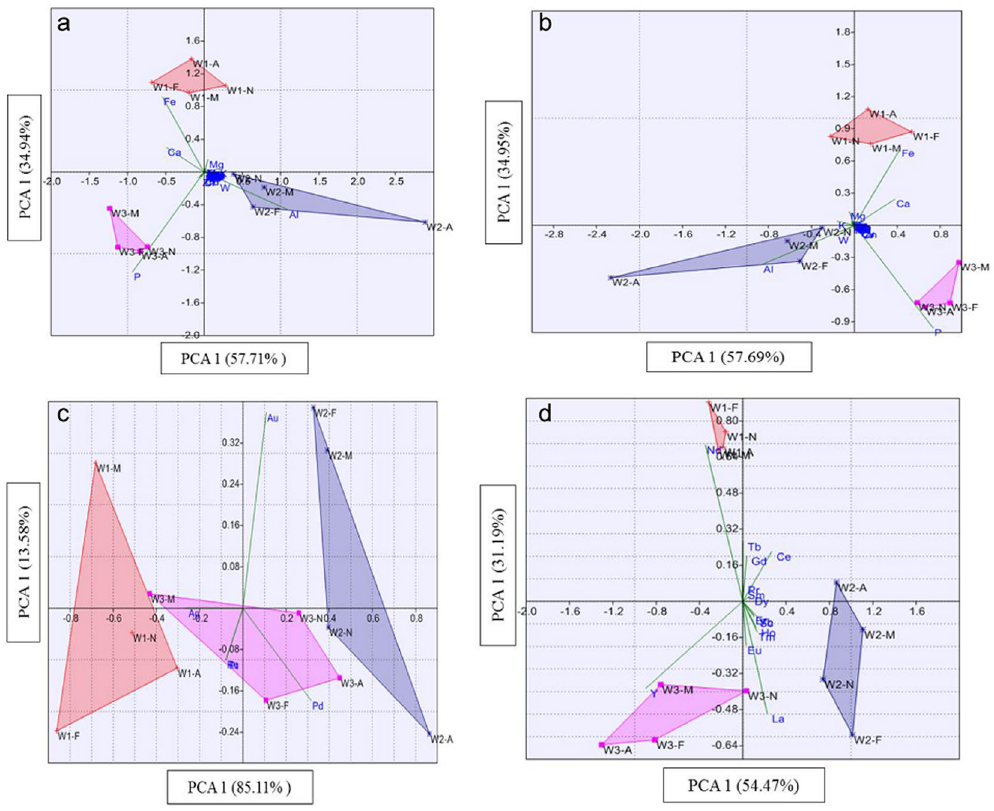
Figure 4. Principal components analysis of ( a ) all detected elements, ( b ) the major industrial elements, ( c ) precious elements and ( d ) rare earth